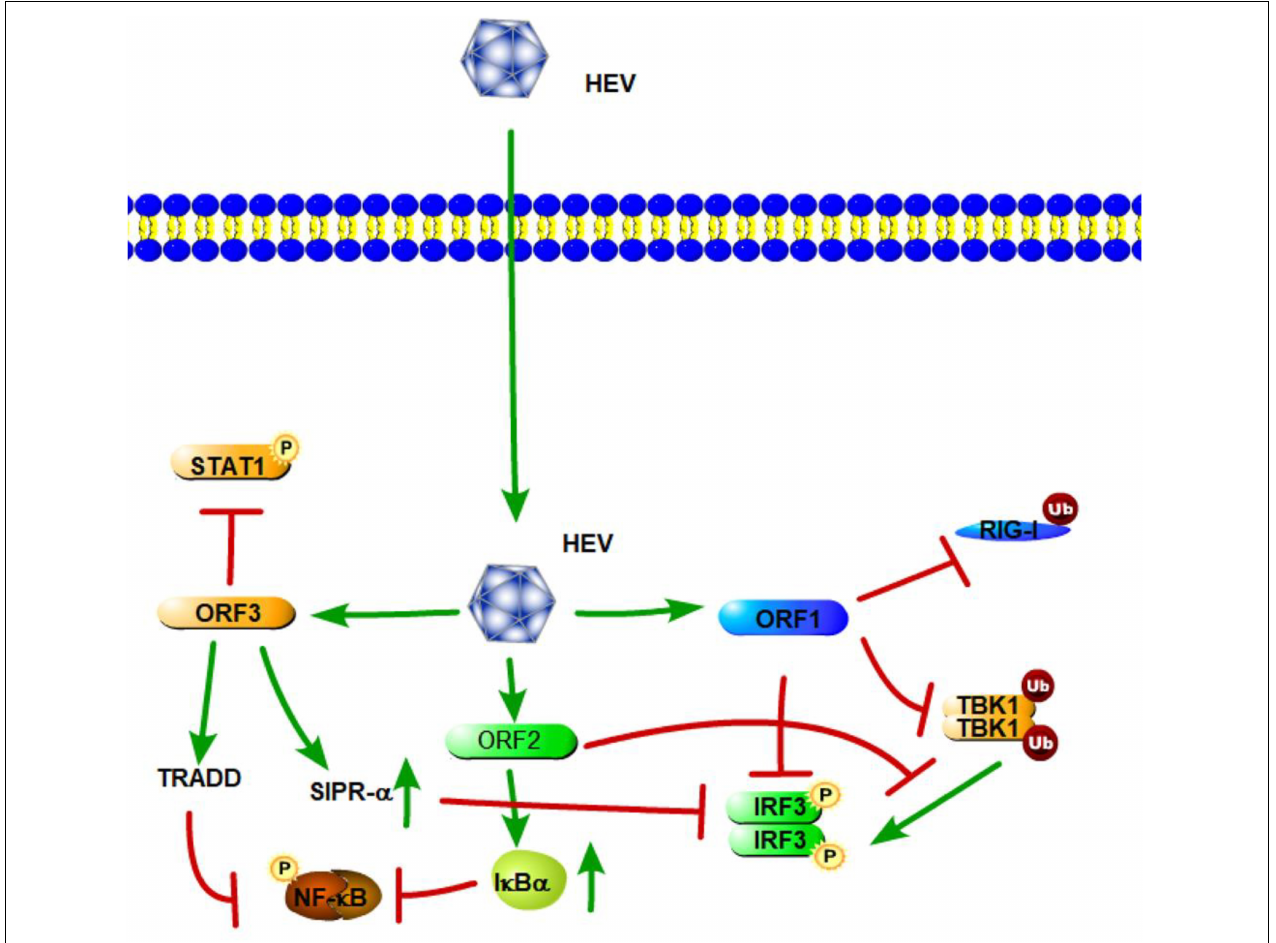
FIGURE 5 | Hepatitis E virus suppression of type I interferon (IFN) response (green arrows indicate the related signaling pathways and T-arrows in red indicate blocking the targets). HEV ORF1 mediates the deubiquitination of RIG-I and TBK-1 and inhibits IRF-3 phosphorylation. The ORF2 protein affects RIG-I and TLR signaling pathways to block the phosphorylation of IRF3 by TBK1. The ORF2 protein also can stabilize inhibitor kappa B alpha (I κ B α ), thereby inhibiting NF- κ B activity. HEV ORF3 contributes to the activation of SIRP- α to downregulate phosphorylation of IRF3. ORF3 of HEV suppresses TLR3-mediated NF- κ B signaling via tumor necrosis factor receptor 1-associated death domain protein (TRADD). HEV ORF3 protein has the ability to inhibit IFN- α signaling through the regulation STAT1